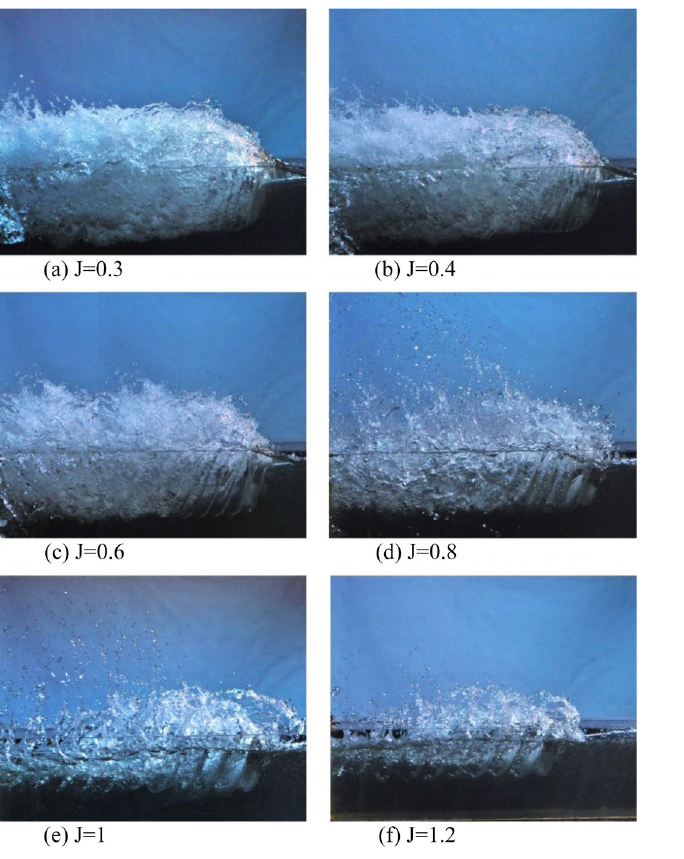
Figure 8. Flow pattern and ventilation development in Fr nD = 2